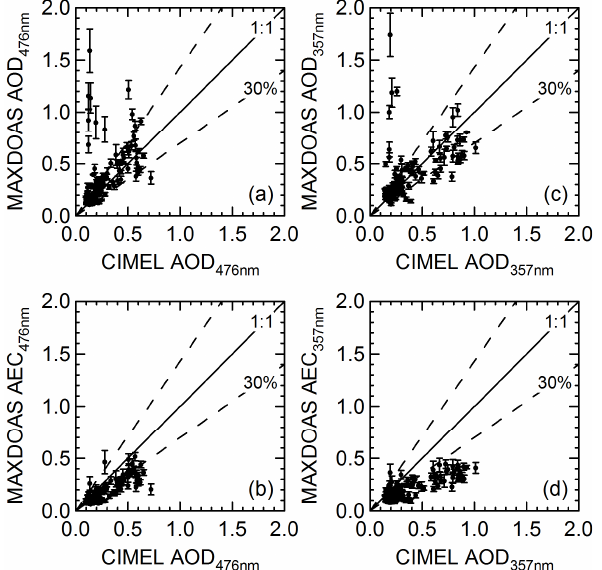
Fig. 6. Correlations between MAX-DOAS aerosol products (AOD and AEC at 0–1km) and CIMEL sunphotometer AOD data. Corre- lations for 476nm ( a and b ) and 357nm ( c and d ) are plotted.